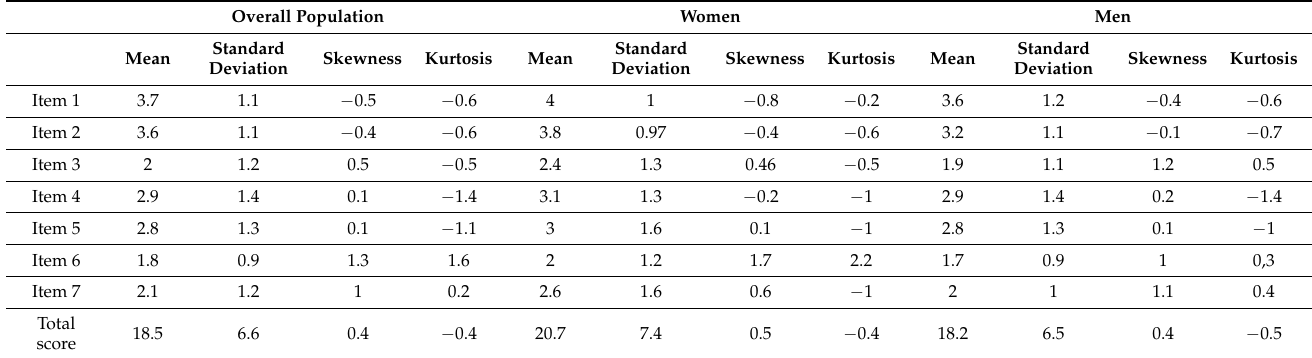
Table 1. Descriptive analysis of the Fear of COVID-19 items by gender.